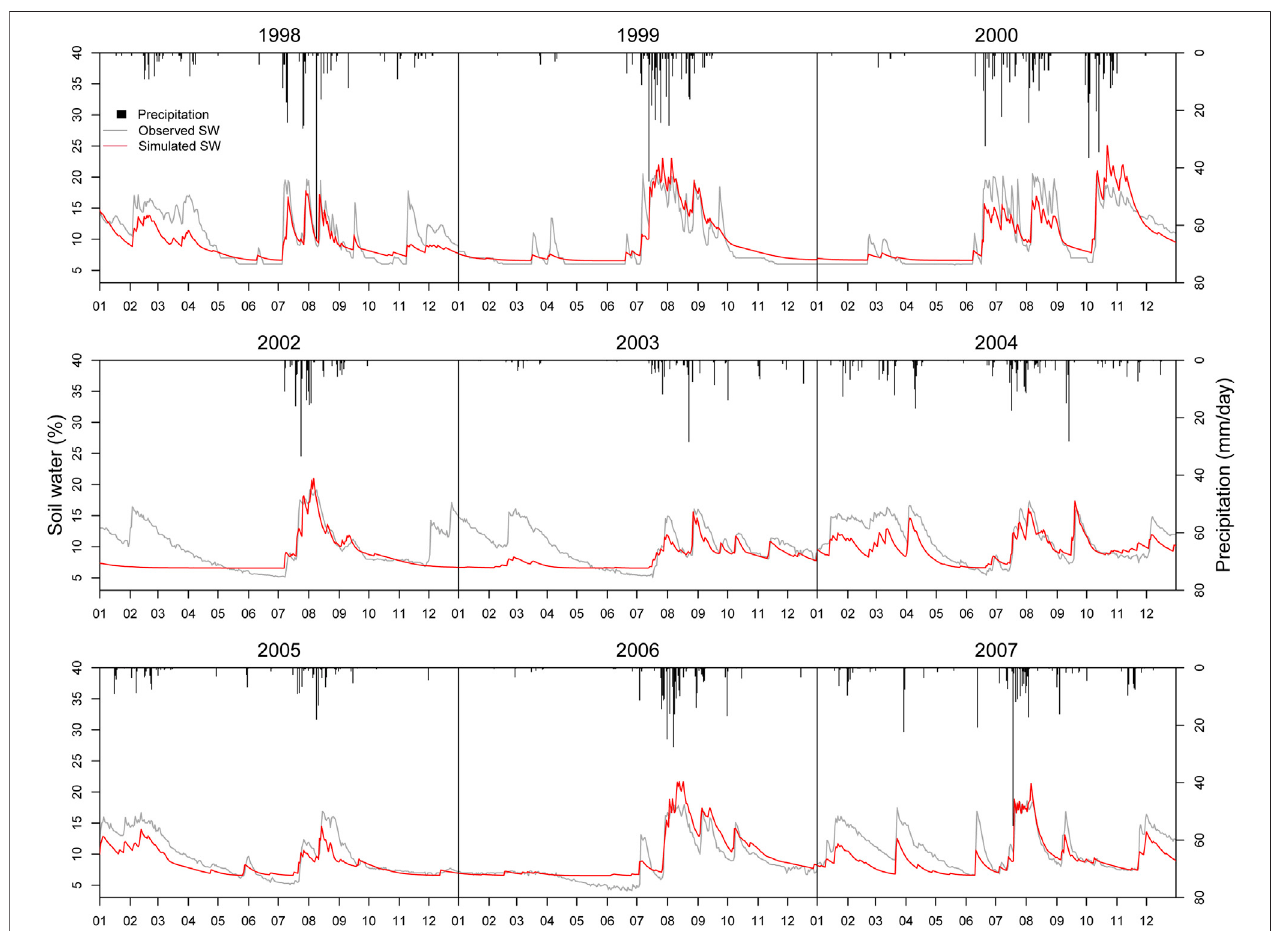
FIGURE 8 | Comparison of simulated and observed daily soil water